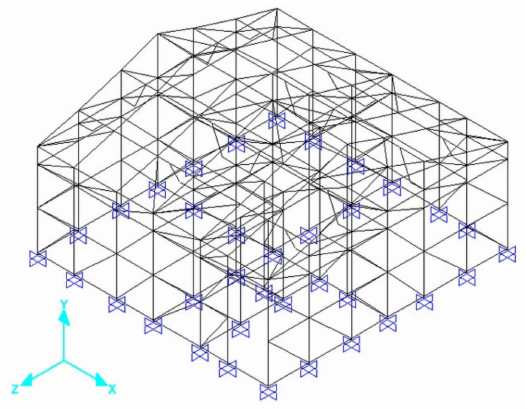
Figure 15. SHS Embryo 2C’s computational model